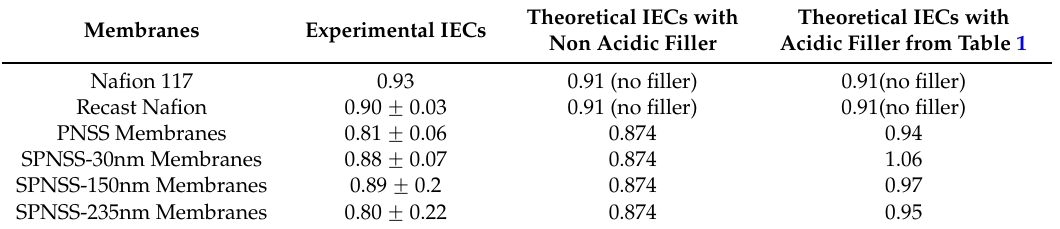
Table 2. Comparison of ionic exchange capacity of SPNSS, PNSS, and Nafion membranes. Membranes Experimental IECs